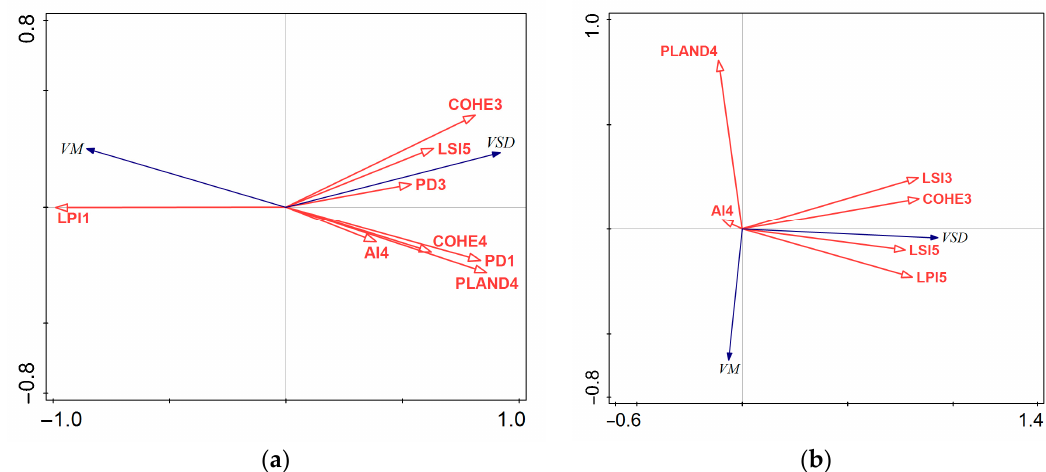
Figure 11. RDA ordination diagram with VM, VSD, and landscape metrics in the residential area (COHESION was abbreviated as COHE due to length limitation): ( a ) 2000; ( b ) 2012. (Note: PLAND = Percentage of Landscape, PD = Patch Density, LPI = Largest Patch Index, LSI = Landscape Shape Index, AI = Aggregation Index, CONTAG = Contagion Index, COHESION = Patch Cohesion Index. VM = volume mean, VSD = Volume Standard Deviation. 1 = Manmade coverage, 2 = Waterbody, 3 = Woodland, 4 = Grassland, 5 = Bare